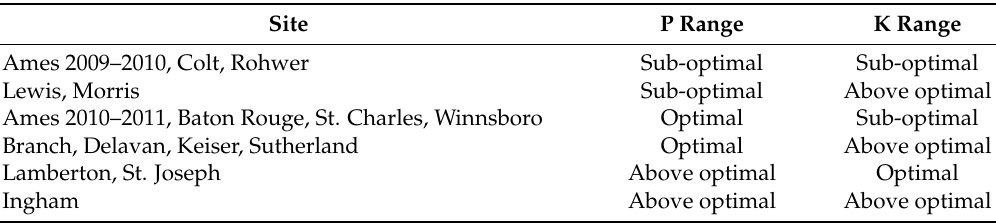
Table 2. Description of site soil test levels used in the study in the years 2009 to